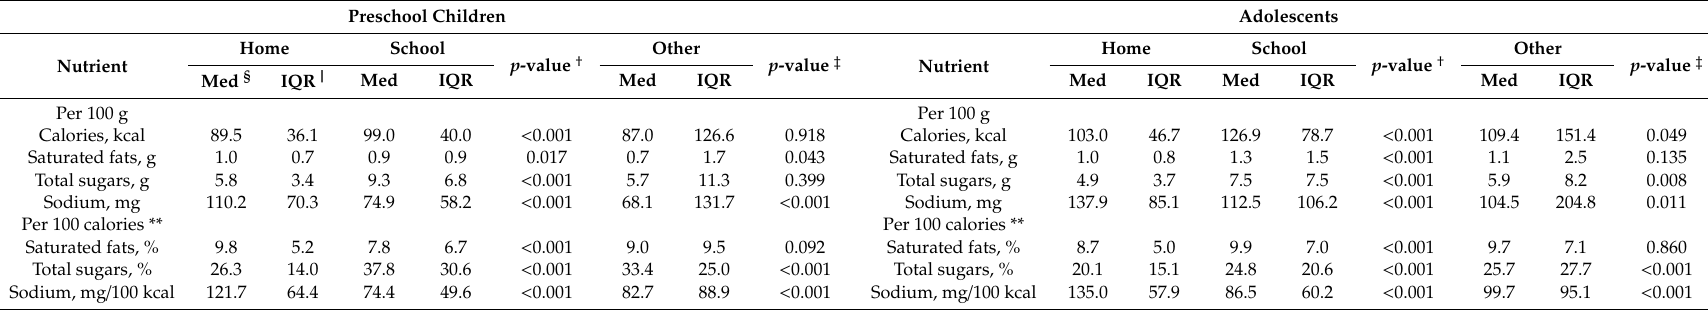
Table 3. Nutrient density per 100 g and per 100 calories by eating location * among low- and middle-income Chilean preschool children and adolescents from Southeast Santiago,